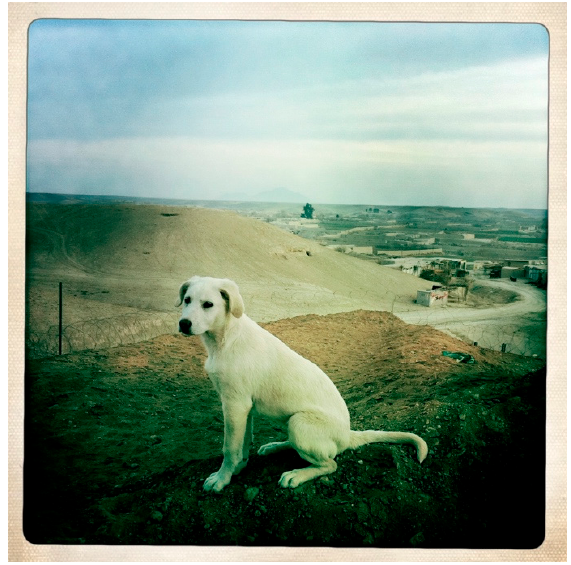
Figure 4. War dog. Source: created by Rita Leistner (used with photographer’s permission).